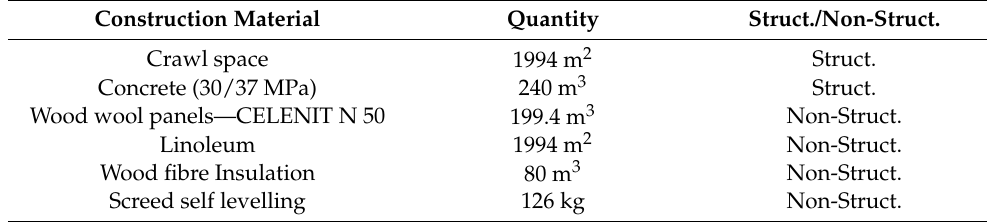
Table 4. Bill of materials: ground floor.